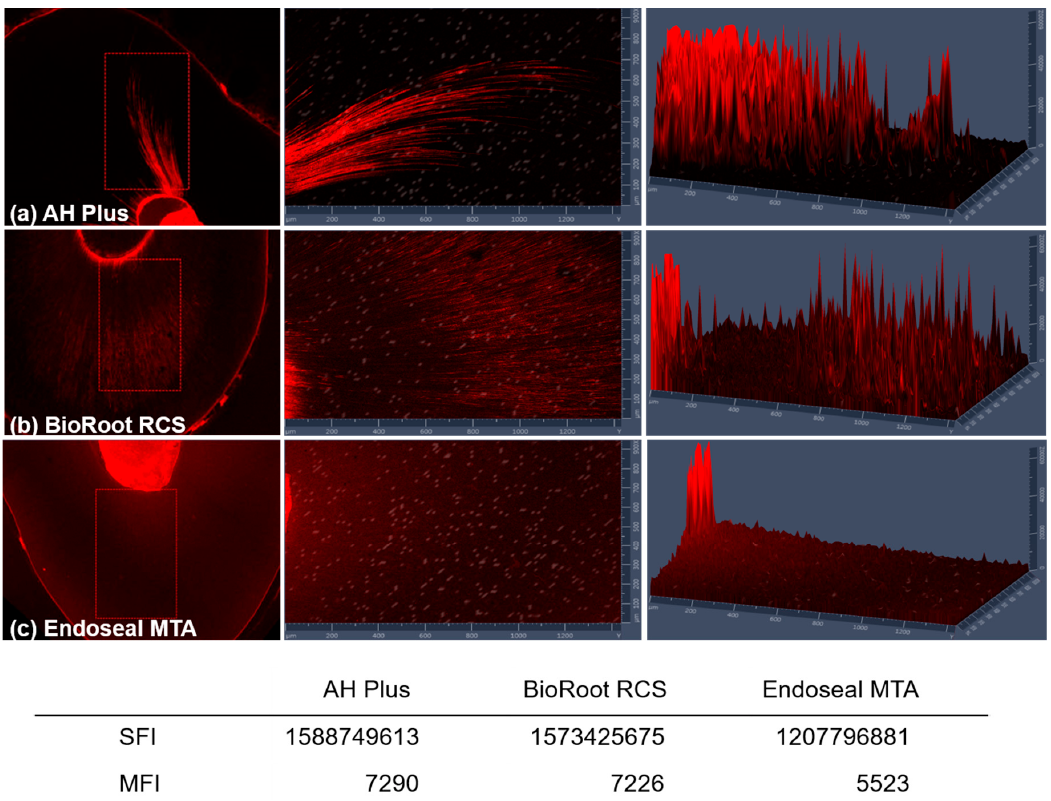
Figure 3. Representative image of a 2.5D histogram of each sealer at the middle third level: ( a ) AH Plus, ( b ) BioRoot RCS, and ( c ) Endoseal MTA. Abbreviations: SFI—sum fluorescence intensity and MFI—mean fluorescence intensity.